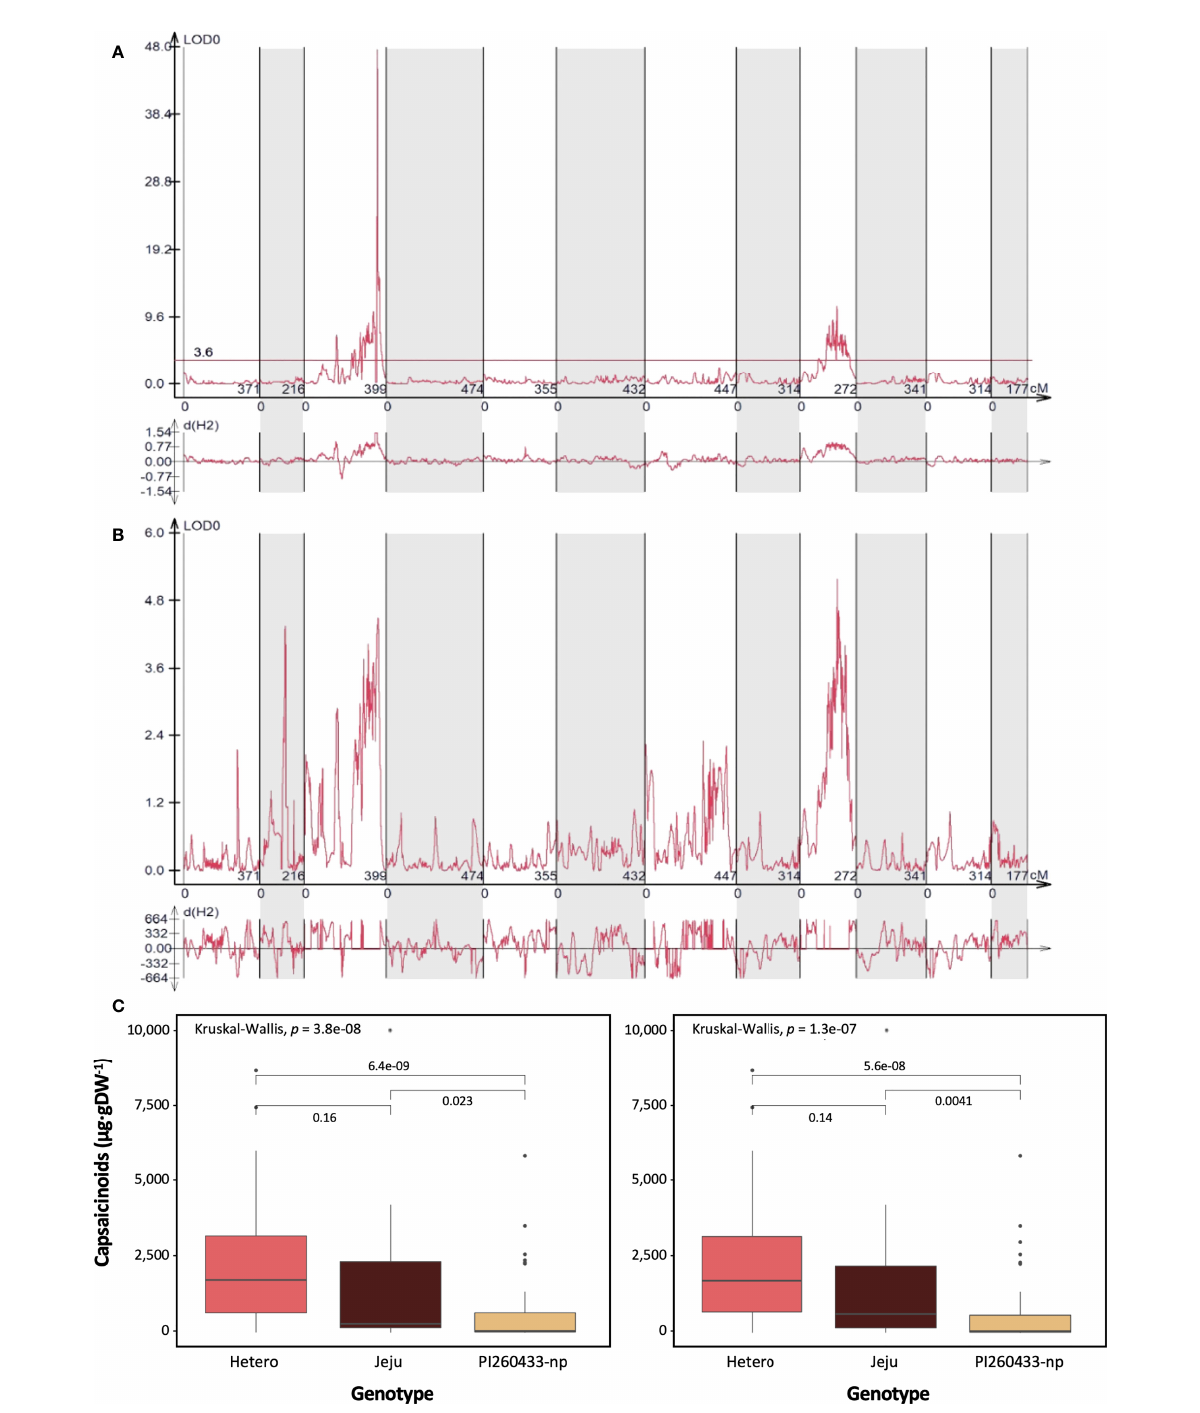
FIGURE 2 QTL mapping of capsaicinoid content in the ‘ PJ ’ F 2 population. (A) The detected QTLs were associated with the phenotypic data from Gibb ’ s analysis. The most dominant QTL was located on chromosome 3, and the other QTL was detected on chromosome 9. (B) The detected QTLs were associated with the phenotypic data from HPLC analysis. No signi fi cant QTLs were detected. (C) Comparison of QTLs and SNPs associated with capsaicinoid content and box plots of capsaicinoid content regulated by two markers representing the two QTLs. Bin markers used for box plot were Bin7_25_1M_249000000 (left) and Bin10_25_1M_204000000 (right) in the ‘ PJ ’ F 2